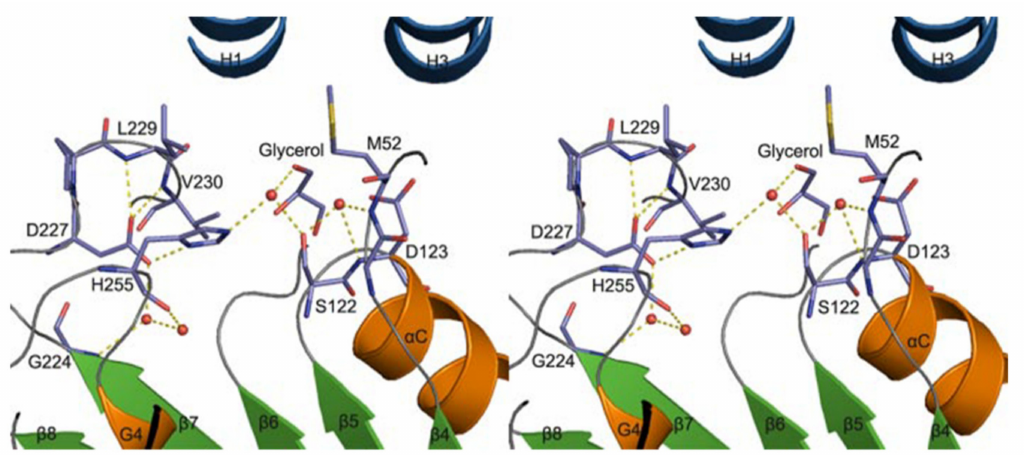
Figure 5. Valacyclovirase active site stereoview (red circles are water molecules). Reproduced with permission from